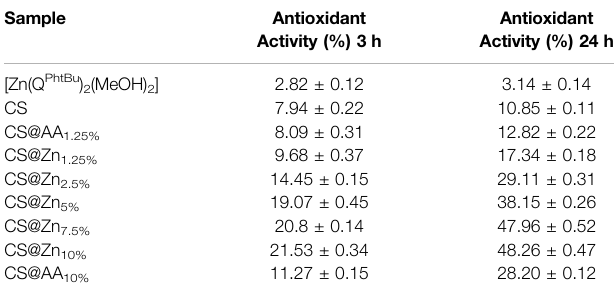
TABLE 1 | DPPH scavenging ability of [Zn(Q PhtBu ) 2 (MeOH) 2 ], CS, CS@AA n (AA = ascorbic acid; n = 1.25 and 10%), and CS@Zn n fi lms.